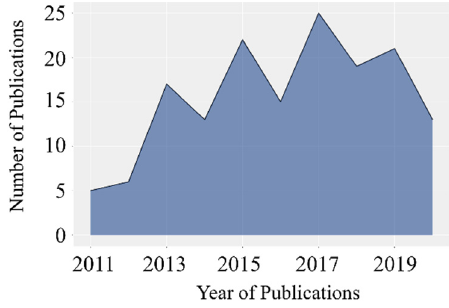
Figure 9. Annual Scientific Production (ROI).